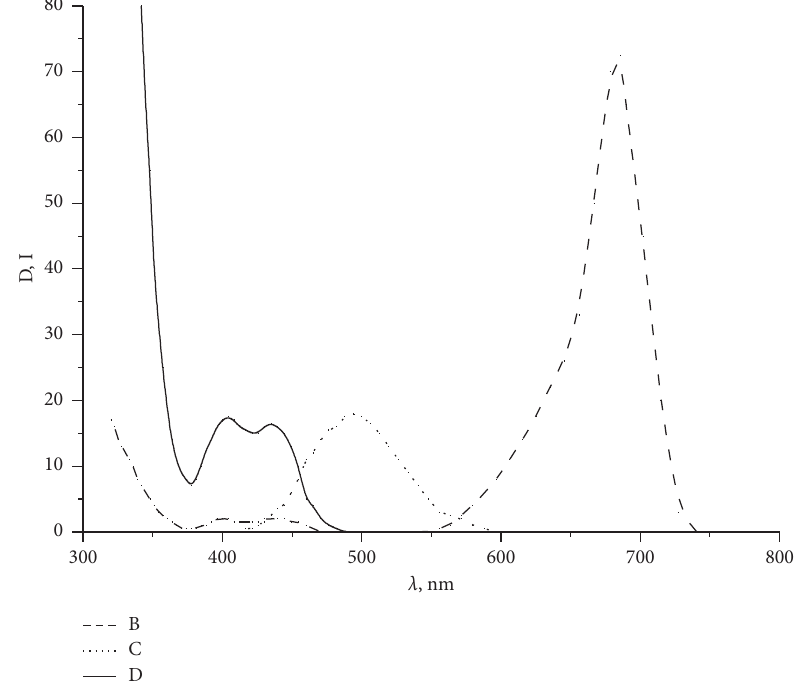
Figure 1: Absorption spectrum of trimethine-di-(4-dimethylaminophenyl) (B), the same spectrum with 10 times increased optical density (D), and the spectrum of (S) 2 ⟶ (S) 0 -fluorescence (C)